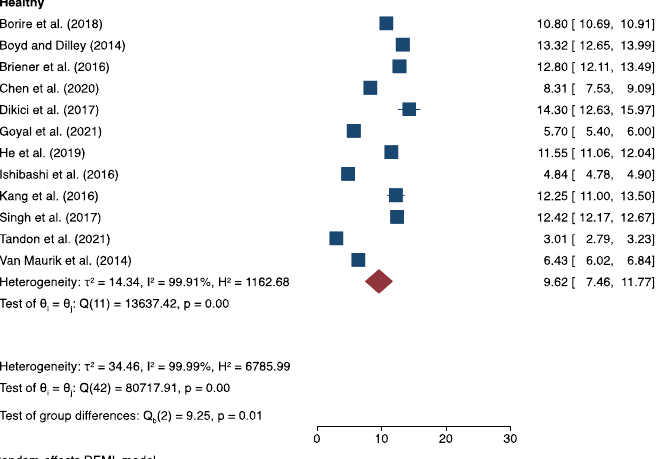
Figure 2. Forest plot showing the pooled tibial nerve cross-sectional area by subgroup. The squares indicate the cross-sectional areas from 16 studies [8–11,13–16,24–31]. Size of each square is relative to the study’s weight. Whiskers indicate the upper and lower limits. Red diamonds indicate the overall cross-sectional area in each subgroup.